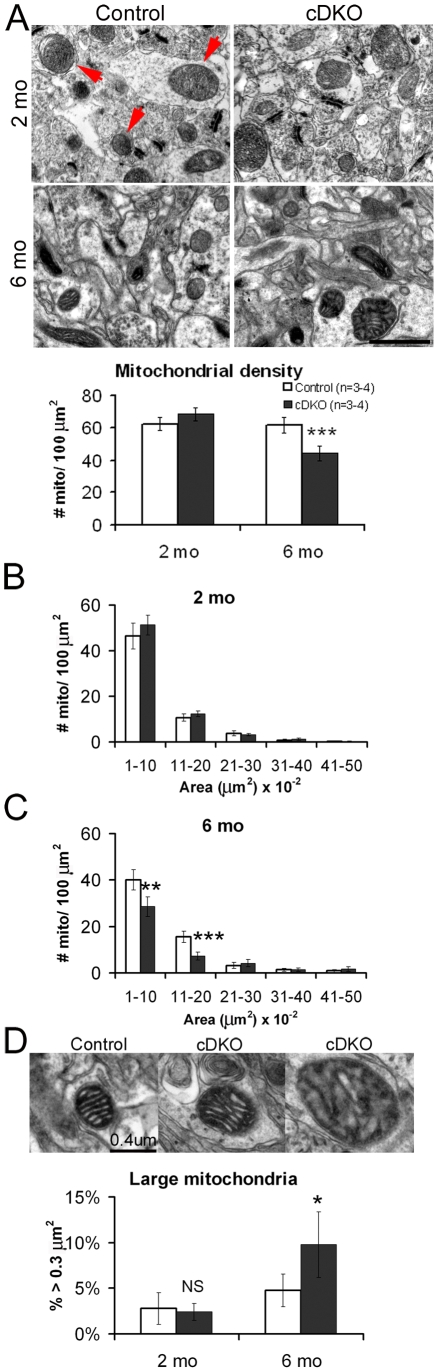
Mitochondrial defects in the cerebral cortex of Psen cDKO mice.(A) (Top) Electron micrographs of mitochondria from the neocortex at 2 months and 6 months of age. Red arrows point to mitochondria typical of those quantified in (A–C). Scale bar, 1 µm. (Bottom) Quantification of mitochondria per 100 µm2 in neocortex. The density of Psen cDKO mitochondria was comparable to controls at 2 months (control: 62.5±4.1 vs. Psen cDKO: 68.4±4.1; p>0.05) but reduced by 6 months (control: 61.7±4.8 vs. Psen cDKO: 44.2±4.6; p<0.001), revealing age-dependent loss of mitochondria in Psen cDKO (n = 4 mice per genotype (2 mo) and 3 mice per genotype (6 mo)). (B,C) Analysis of size distribution of cortical mitochondria determined that Psen cDKO has no change in mitochondrial morphology at 2 months (B), but a sizeable reduction in small mitochondria by 6 months of age (C) (0.01–0.1 µm2 bin: control, 40.0±4.4 vs. Psen cDKO, 28.6±4.3 (p<0.001); 0.11–0.2 µm2 bin: control, 15.5±2.3 vs. Psen cDKO, 7.3±1.6 (p<0.00001)). (D) (Top) High-magnification electron micrographs of cortical mitochondria from mice at 6 months of age. Both control (left) and Psen cDKO samples (middle) have normal mitochondria with clearly visible cristae and outer membrane structures; however, Psen cDKO mice also have a slight increase in the number of swollen mitochondria (right). Scalebar, 0.4 µm (all 3 images). (Bottom) Quantification of large (area >0.3 µm2) mitochondria from mice age 2 months and 6 months. The percentage of large Psen cDKO cortical mitochondria relative to the total number was normal at 2 months of age (control: 0.028±0.017 vs. Psen cDKO: 0.024±0.009; p>0.05), but at 6 months of age, the percentage of large Psen cDKO mitochondria is twice the number observed in controls (control: 0.048±0.018 vs. Psen cDKO: 0.098±0.035; p<0.05), implicating a dysregulation of mitochondrial morphology in the absence of PS function. (n = 4 at 2 months and 3 at 6 months). All data are presented as the mean ± s.e.m.